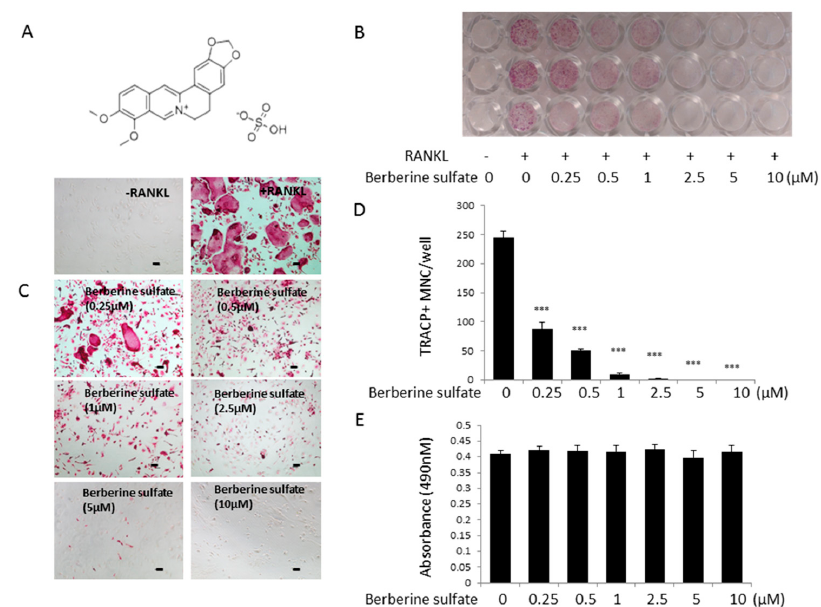
Figure 1. Berberine sulfate inhibits RANKL-induced osteoclastogenesis in BMM cells. ( A ) Chemical structure of berberine sulfate. The molecular weight of berberine sulfate is 433.43; ( B ) The 96 well-plate showing the effects of different concentration of berberine sulfate on the BMMs derived osteoclast-like cell formation. BMM cells (6 × 10 3 cell/well) were cultured in the presence of M-CSF and GST-rRANKL (50 ng/mL) with or without different concentration of berberine sulfate for five days. Then, the cells were stained for TRAcP. “ − “ means RANKL untreated; and“+” means RANKL treated; ( C ) Enlarged images of B (scale bar: 100 μ m); ( D ) Osteoclast cell counts showing TRAcP-positive multinucleated cells. ( n = 3); ( E ) Effect of berberine sulfate on the viability of BMM cells as measured by MTS assay. ( n = 3). *** p < 0.001 ( versus RANKL-treated control).